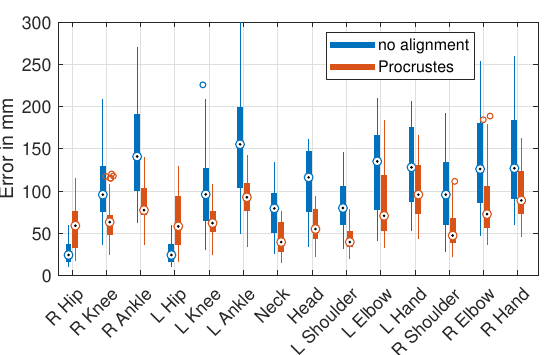
Figure 7. Jointwise no-alignment and Procrustes error of all single-database training results. Box plot with median (circle with dot), 1’st/3’rd quartile (bottom/top of thick bar), and outliers (circles, default settings of MATLAB 2017b).